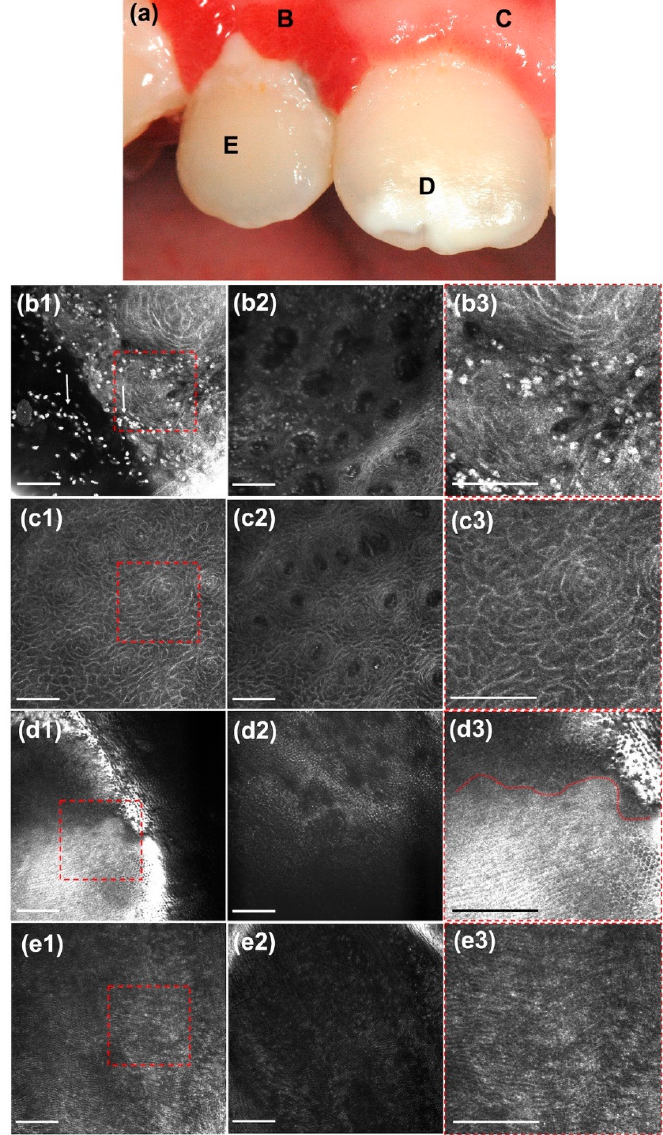
Figure 1. Examples of in vivo RCM images of the hard and soft oral tissues. ( a ) The clinical picture shows the points corresponding to the RCM frames: B, gingivitis, reported in b1-3; C, healthy gingiva, corresponding to frames c1-3; D, enamel defect, reported in d1-3; E, healthy enamel, shown in e1-3. ( b1 ) Gingival epithelial surface, showing a massive presence of bacterial plaque (white arrows) covering the mucosal surface. ( b2 ) Inflammation persists up to the basal epithelial layers with blood cells within the subepithelial and basal epithelial layers. ( b3 ) Higher magnification of the bright roundish dental plaque bacteria from the picture in the red square of b1. ( c1 ) Healthy mucosa at the intermedium epithelial layers. ( c2 ) Healthy mucosa at the basal layer. ( c3 ) Higher magnification of the regularly organized keratinocytes from the picture in the red square of c1. ( d1 , d2 ) Within the hypomineralized dental areas, a dark appearance and lack of interprismatic structures alternate with regular enamel through the enamel layers, magnified in ( d3 ), where the red line has marked the boundaries between organized mineralized enamel and demineralized one. ( e1 , e2 ) The healthy enamel shows the classical architecture, given by the regular presence of enamel prisms and interprismatic substance, from the surface ( e1 ) up to the last visible layer ( e2 ). ( e3 ) At a higher magnification, healthy enamel shows a bright interprismatic organic substance surrounding dark regular enamel prisms. Scale bars: 100 µ m. [original pictures from the